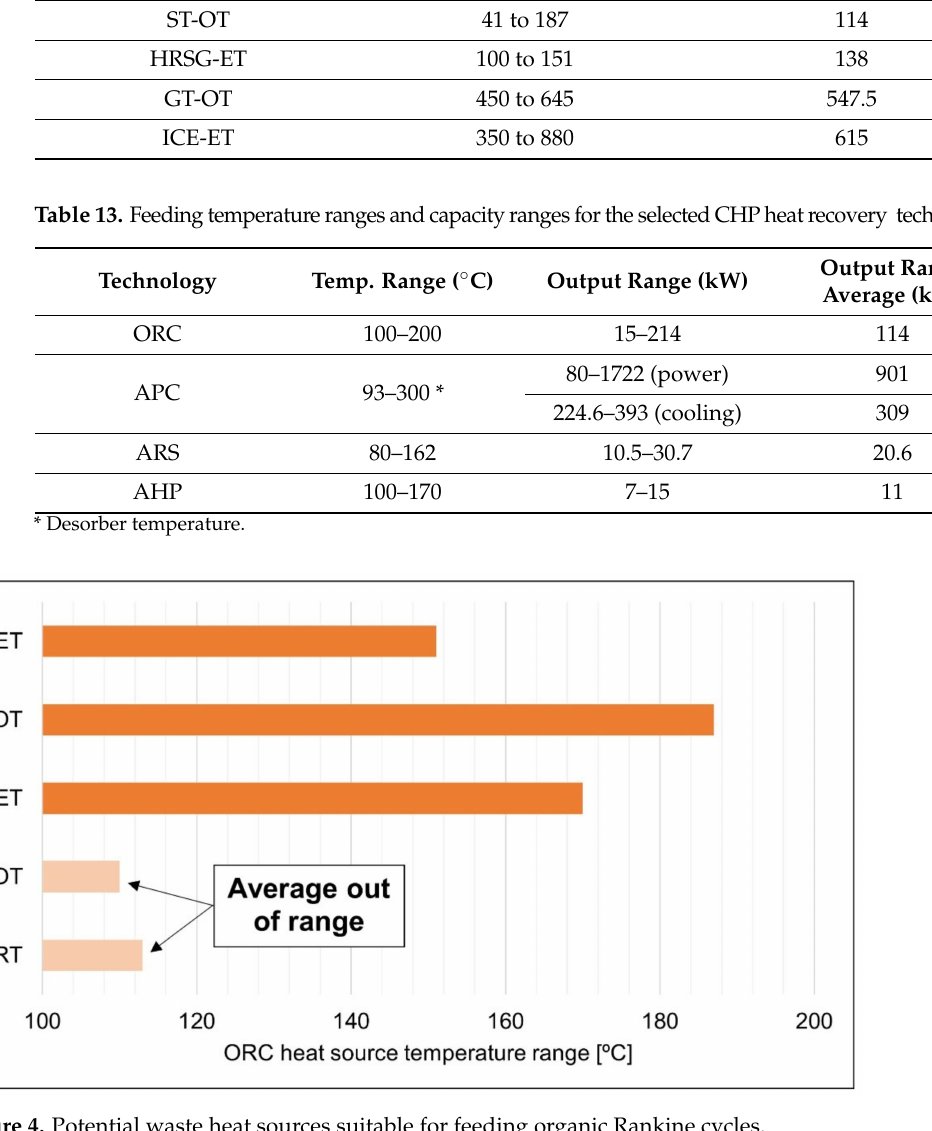
Figure 4. Potential waste heat sources suitable for feeding organic Rankine